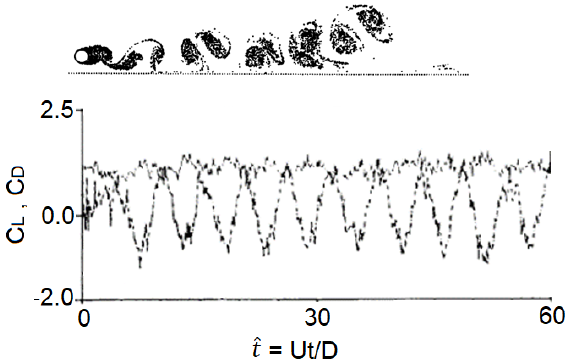
Figure 14. The flow pattern and force coefficients for G/D = 1 and Re = 1000.